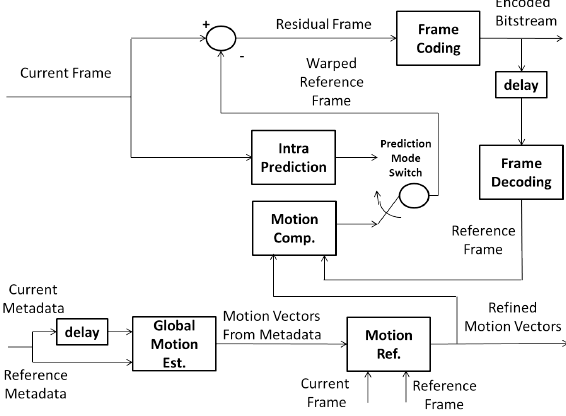
Figure 1: Sensor aided video encoder scheme.